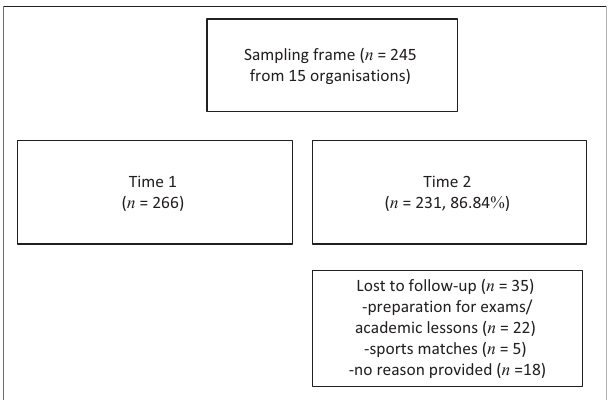
FIGURE 1: Flow diagram of screening